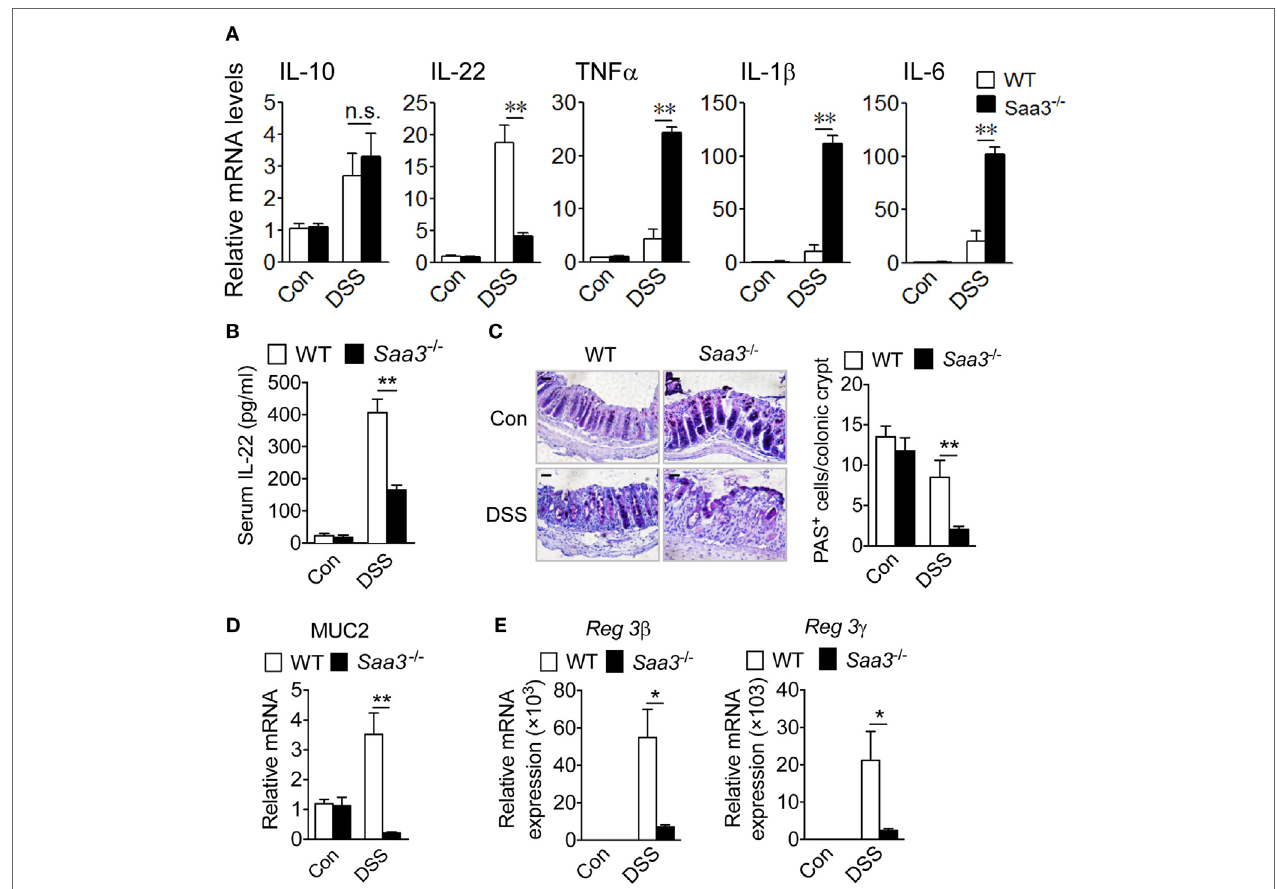
FigUre 3 | Expression of cytokines, mucin, and antimicrobial peptides in wild type (WT) and Saa3 − / − mice receiving dextran sulfate sodium (DSS). (a) The relative mRNA levels of regulatory cytokines (IL-10 and IL-22) and inflammatory cytokines (TNF α , IL-1 β , and IL-6) were measured with quantitative RT-PCR. (B) Changes in serum IL-22 levels WT and Saa3 − / − mice. (c) Representative images showing PAS + goblet cells in colon sections from WT and Saa3 − / − mice treated with DSS or water. Scale bars, 20 µm. Quantitative data ( n = 5) are shown on the right. (D) Relative mRNA levels of MUC2 in WT and Saa3 − / − mice. (e) Relative mRNA levels of Reg3 β (left) and Reg3 γ (right) in the colon tissue from WT and Saa3 − / − mice. All data above were obtained using male and female mice ( n = 5) of 8–10 weeks of age that were treated for 7 days with DSS or water. Shown in bar charts above are mean ± standard margin of error of triplicate measurements. * p < 0.05 and ** p < 0.01; n.s.,